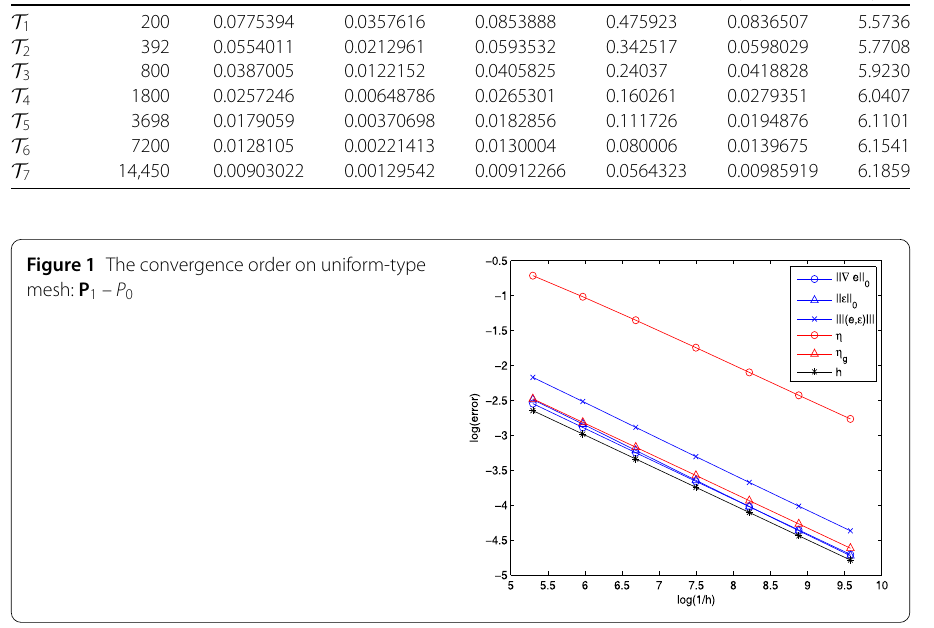
Table 2 Errors, estimators and effectivity ratio: P 1 – P 1 Meshes